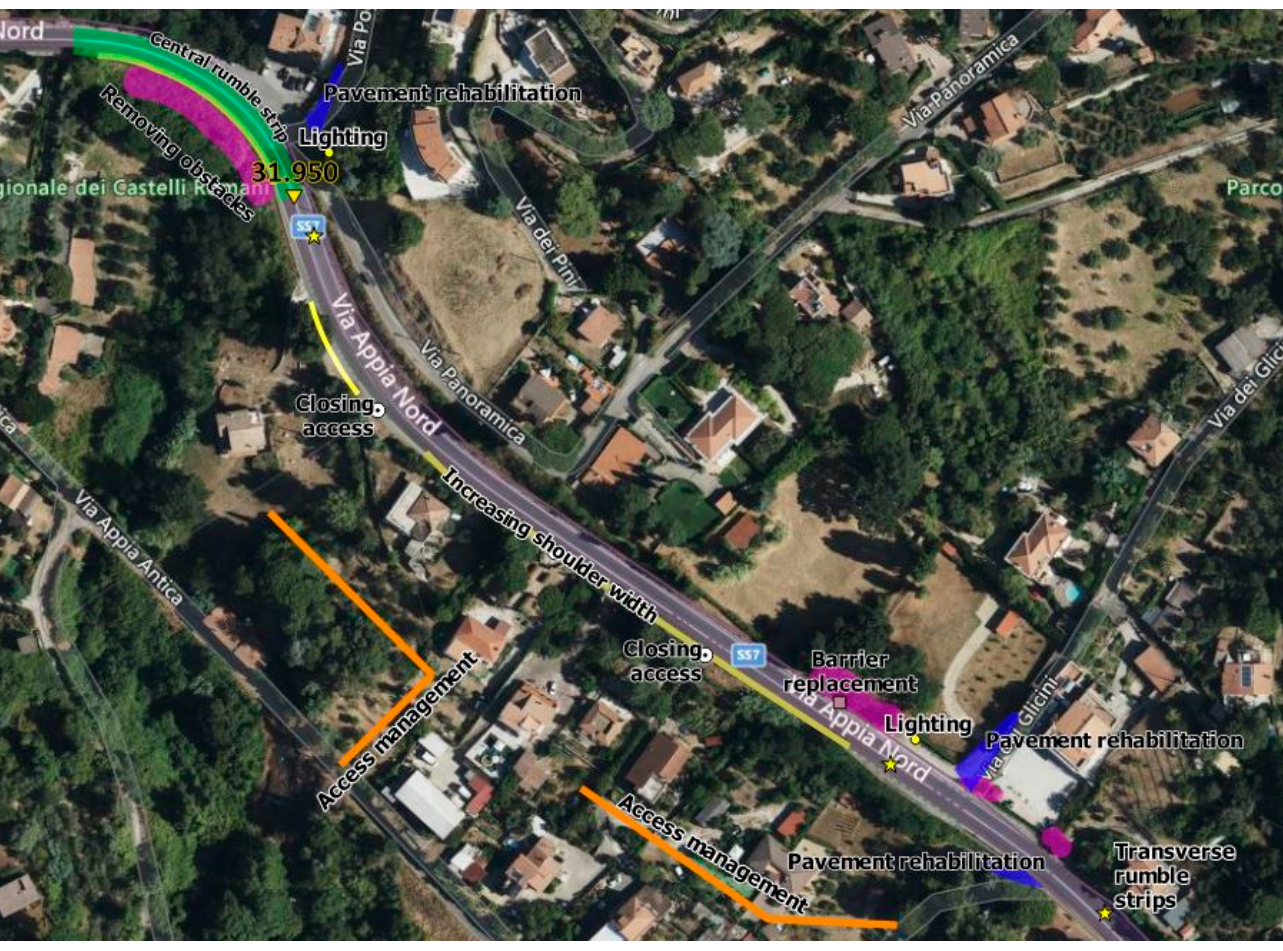
Figure 9. Location of the intervention measures provided for road Section 4.